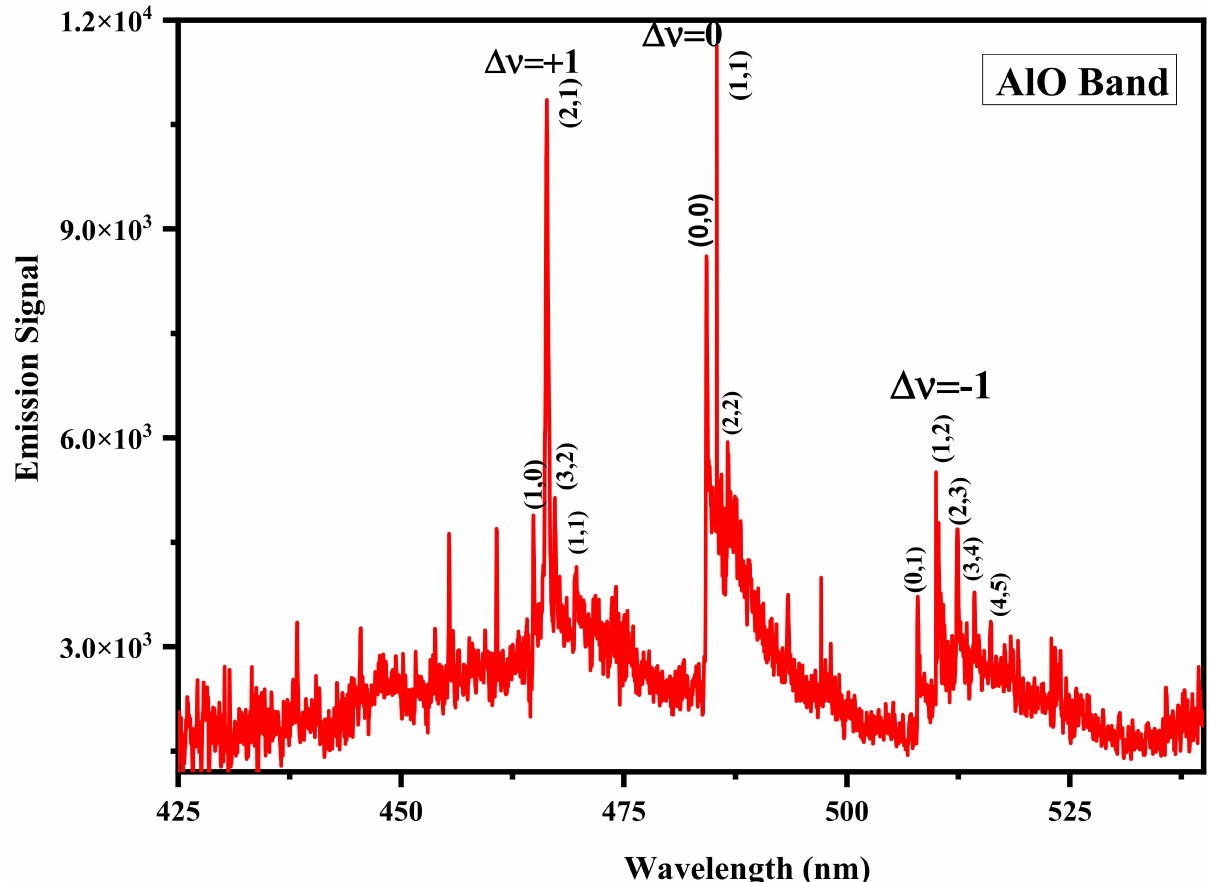
Figure 4. LIBS spectra of S2 crackers in the spectral range of 425–525 nm show the presence of electronic bands of